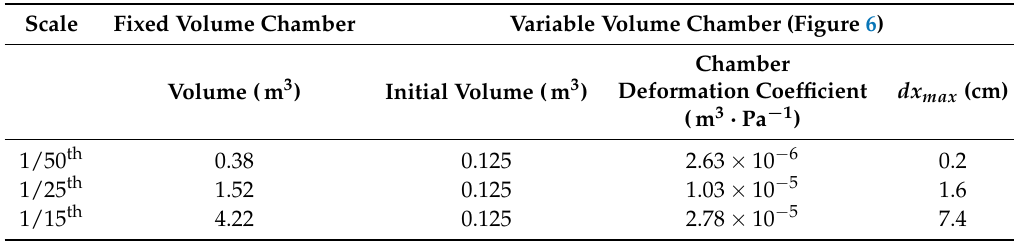
Figure 6. Example of a variable volume chamber with an adjustable deformation coefficient. Table 1. Physical modelling requirements for the modelling of air compressibility effects in a 950m 3 chamber of the Tupperwave full-scale